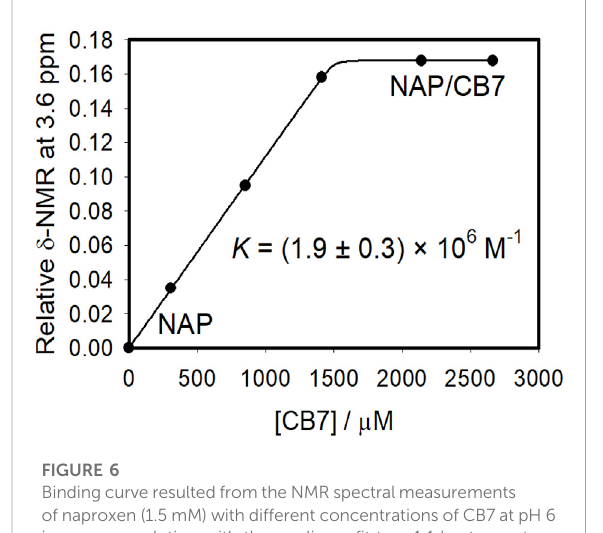
FIGURE 6 Binding curveresulted from theNMR spectralmeasurements of naproxen (1.5 mM) with different concentrations of CB7 at pH 6 in aqueous solution with the nonlinear fi t to a 1:1 host − guest bindingmodel(solidlineandExperimentalSection).Thepeak at~3.59ppm(CH)wasmonitoredtoconstructthebindingtitration plot. Δδ representsthedifferencebetweentheNMRpeakforCHin the absence and presence of CB7